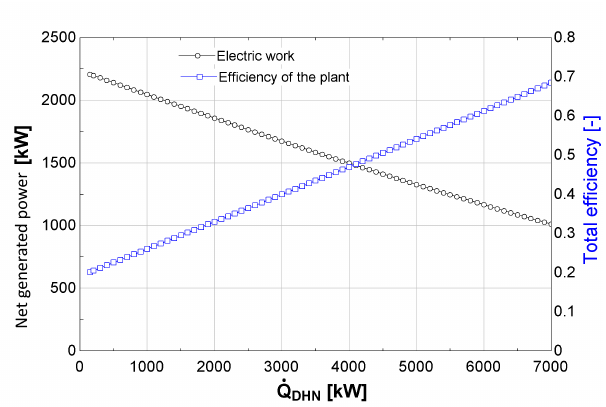
Figure 1. Combined Heat and power plant plant performance in function of the thermal output of the plant (validated on experimental